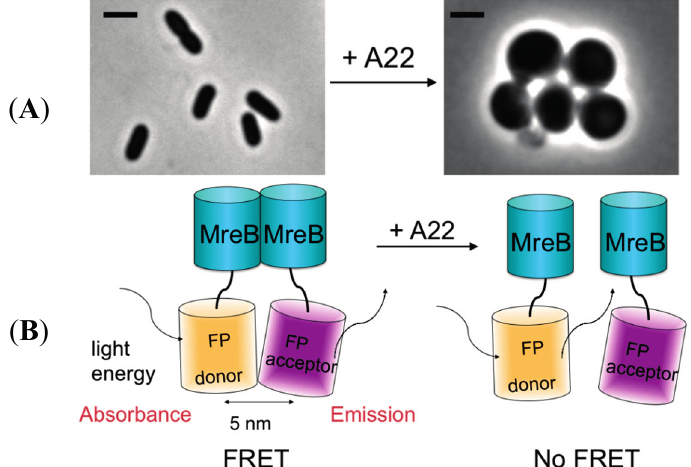
Figure 2. The principle of the in cell FRET antibiotic-screening assay. The interaction between MreB molecules is essential for normal rod-shape growth in wild type